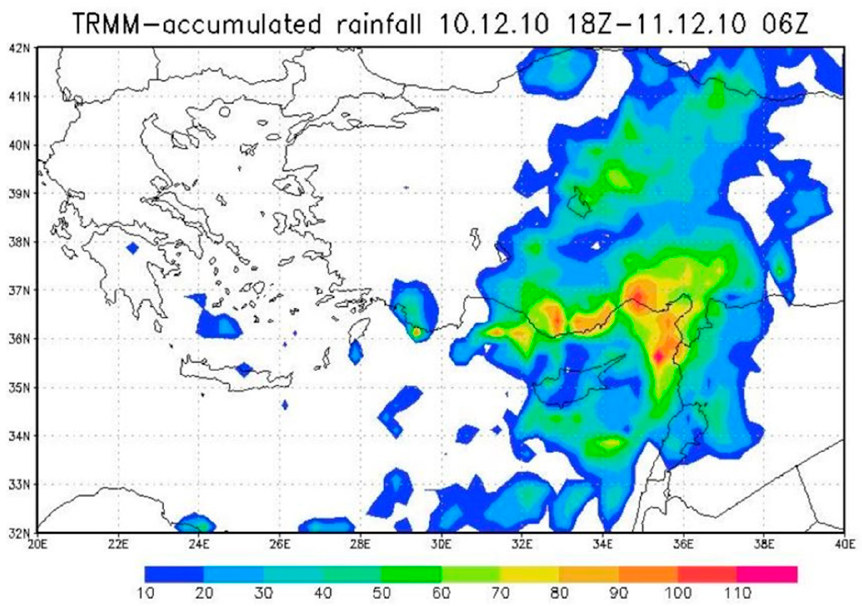
Figure 8. TRMM—TRMM 12 h accumulated rainfall (mm) during the explosive cyclogenesis phase from 10 December 2010 18:00 UTC to 11 December 2010 06:00 UTC [22].